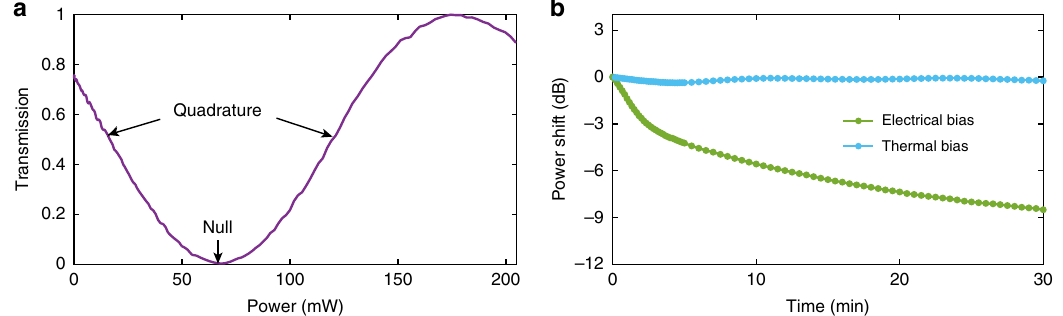
Fig. 2 TO phase shifters performance. a TO transmission curve as a function of the power dissipations. b Power shift from an MZM biased at quadrature using EO (green line) and TO (blue line) phase shifters as a function of the operating